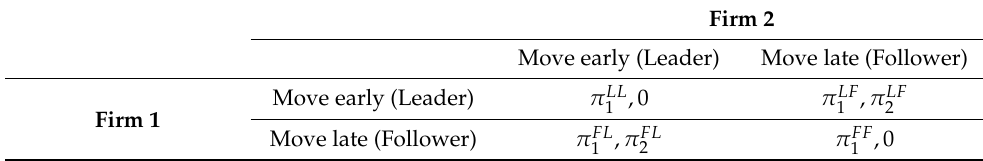
Table 2. Pricing timing and profits